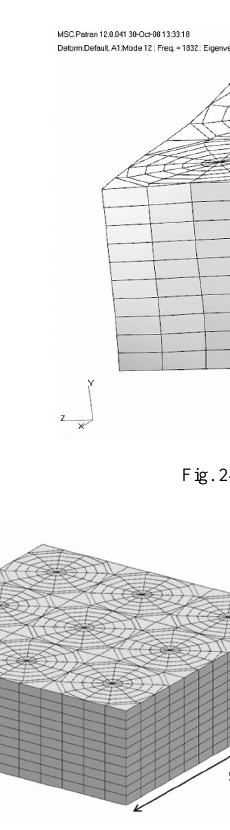
Fig. 25. Nona-cell dynamic